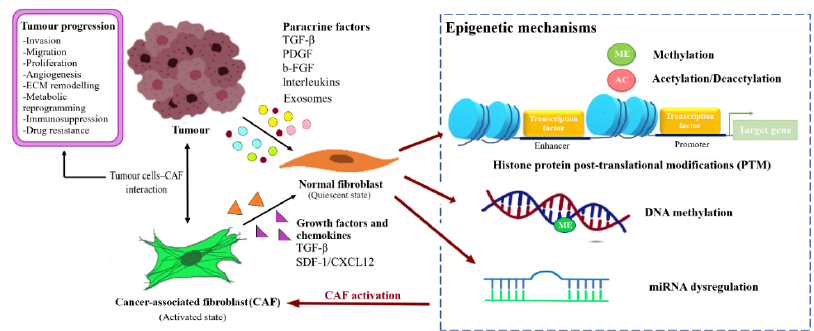
Figure 2. Reprogramming of NFs into CAFs through epigenetic regulation. Fibroblast activating factor secreted by the tumour cells or CAFs caninduced transformation of the normal resident fibroblast into CAFs through epigenetic modulation, and subsequently support tumour